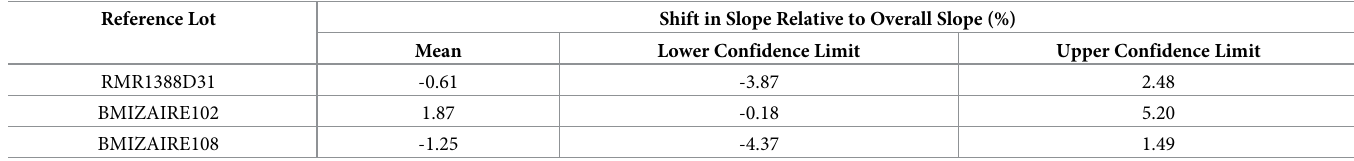
Table 3. Estimated shift from the overall slope for each RS